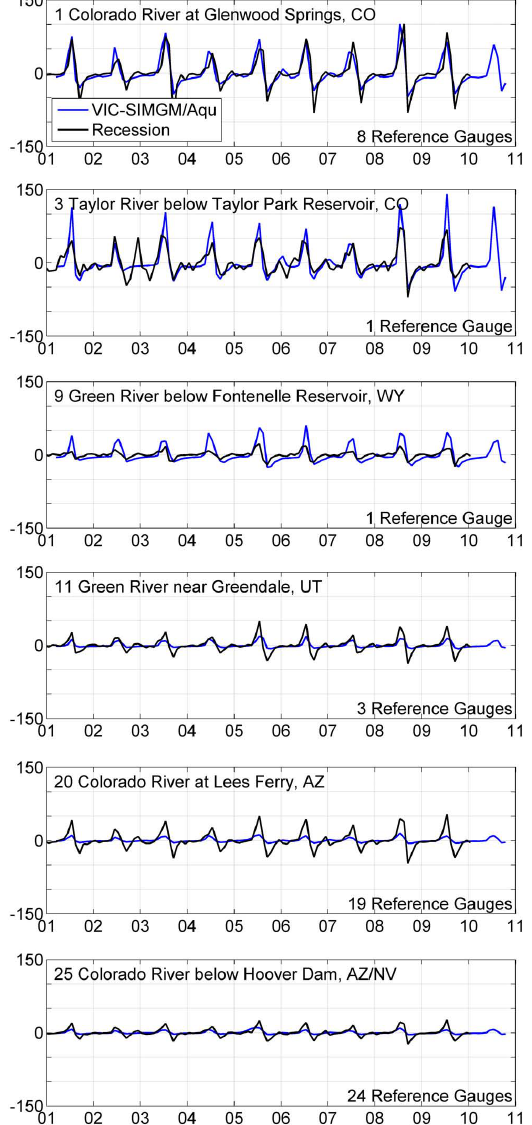
Fig. 9. Comparison of monthly change in groundwater storage (y- axis, in mm) as derived from VIC-SIMGM and recession analysis. The number of reference watersheds used for each sub-basin is pro- vided at lower right.